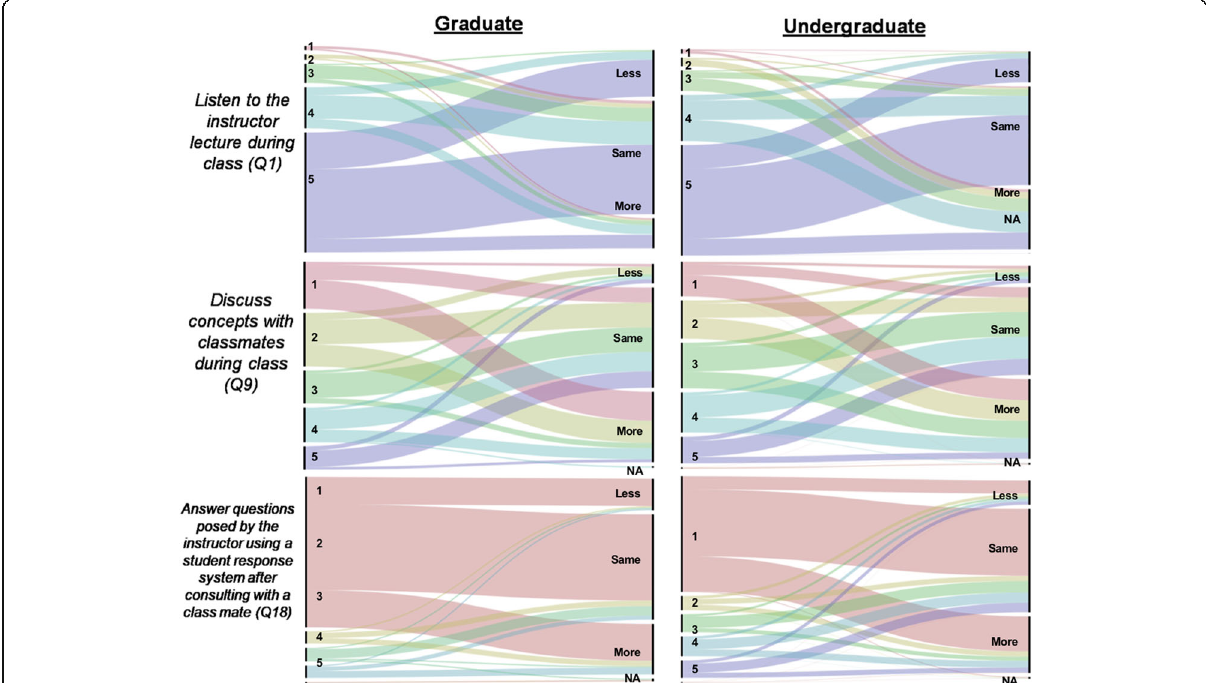
Fig. 4 Alluvial plots of how often students reported experiencing a teaching practice and how much that teaching practice is desired for graduate students (left column) and undergraduates (right column). The vertical bars are the experienced frequency (left) and the vertical height of each bar is proportional to the number of respondents who chose that response. The “ alluvia, ” or lines between columns, indicate how often students reported experiencing a teaching practice (left side of each graph) and how much that teaching practice was desired (right side of each graph) and are proportional to the number of respondents. NA = respondents who did not respond to a particular question; 1 = Never or almost never (0 – 10% of the time); 2 = Seldom (11 – 30% of the time); 3 = Sometimes (31 – 50% of the time); 4 = Often (51 – 70% of the time); 5 = Very often (71 – 100% of the time). Less = a combination of Much less and Slightly less desired; Same = About the same; More = a combination of